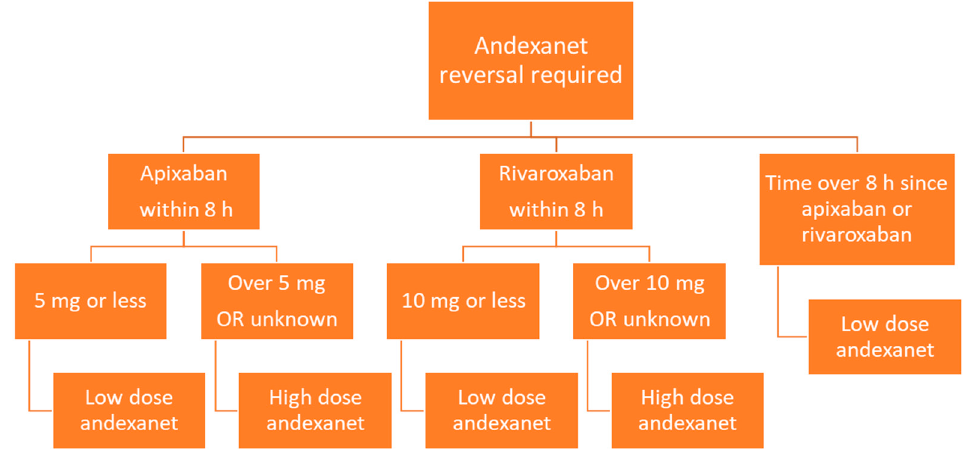
Figure 3. Flow diagram of andexanet dosing based on factor Xa inhibitor, dose, and time since last dose. Table 2. Dosing of andexanet alfa.